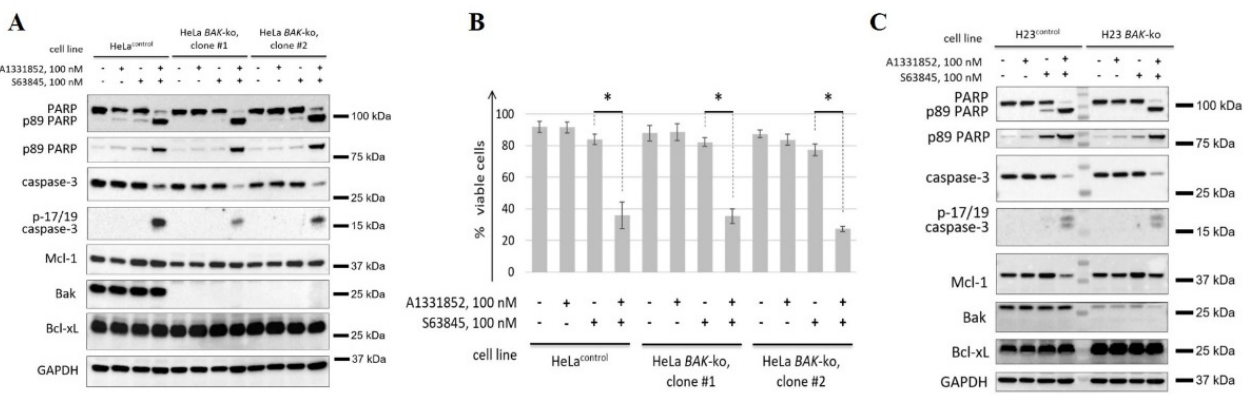
Figure 6. Analysis of the efficiency of concomitant inhibition of Mcl-1 and Bcl-xL in Bak-knockout cells. ( A , C ) WB analysis of HeLa ( A ) or H23 ( C ) cells with or without knockout of BAK1. Cells were treated with 100 nM S63845, 100 nM A1331852, or both. For HeLa cells ( A ), control cells and two independent clones with CRISPR/Cas9-mediated knockout of BAK1 were analyzed. For H23 cells ( C ), control cells and total population of cells with CRISPR/Cas9-mediated knockout of BAK1 were analyzed. ( B ) FACS analysis of HeLa cells with or without knockout of BAK1. Cells were treated as described in ( A ). Data from n = 3 biological replicates are shown as mean ± s.d., * p < 0.05; % viable cells—cells negative for both Annexin V-FITC and propidium iodide (PI). GAPDH was used as a loading control. Time of incubation: 6 h.